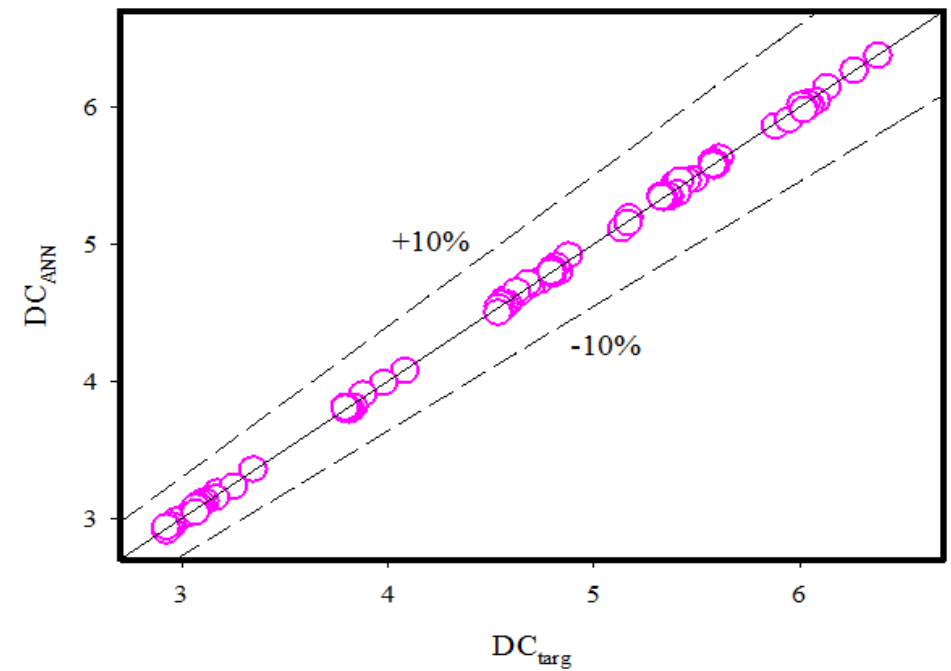
Figure 11. The target values and the ANN outputs.